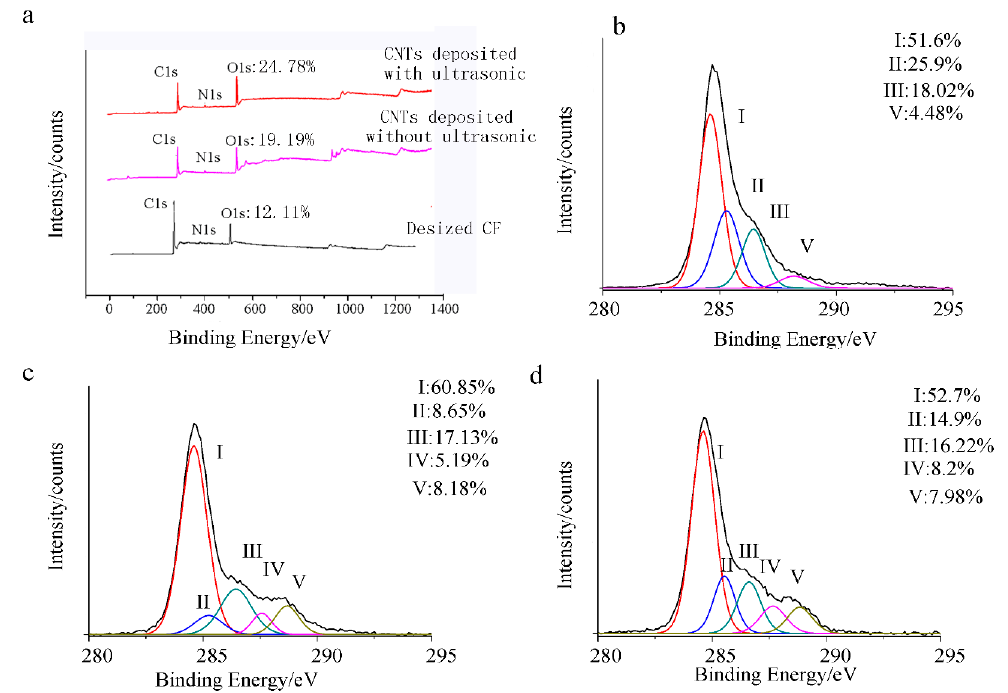
Figure 4. ( a ) The X-ray photoelectron spectroscopy (XPS) wide-scan spectra; ( b ) C1s spectra of desized carbon fiber (CF); ( c ) C1s spectra of desized CF without ultrasonic; ( d ) C1s spectra of desized CF with ultrasonic.